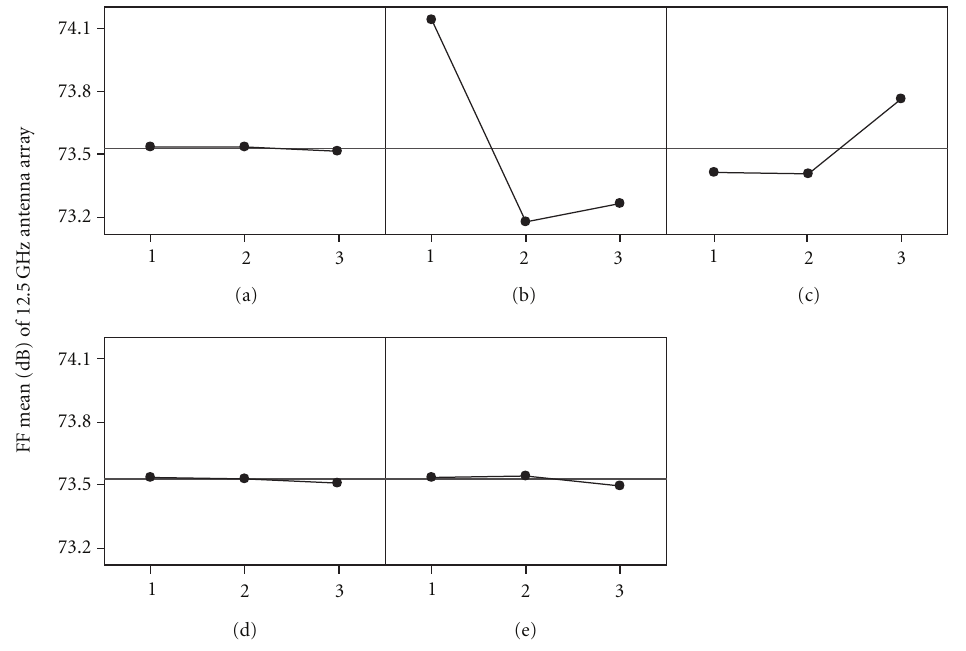
Figure 4: Main e ff ects plot of the antenna’s parameters variance at the achieved optimum